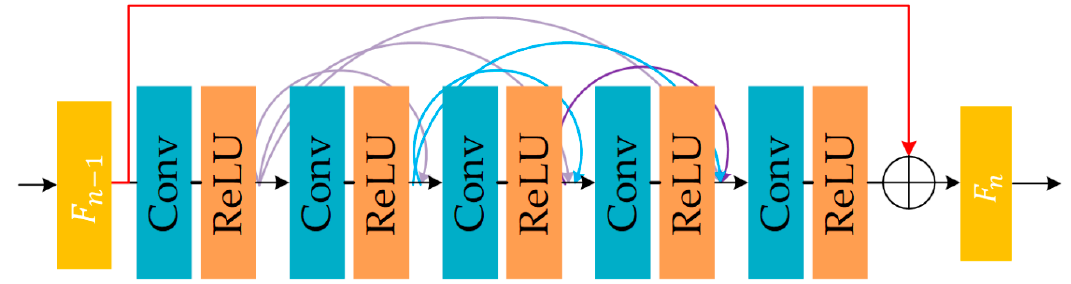
Figure 5. The structure of our recursive inference block. The red line denotes the local residual learning path. 𝐹 (cid:3041)(cid:2879)(cid:2869) denotes the output from the last recursion, and 𝐹 (cid:3041) denotes the output of the current